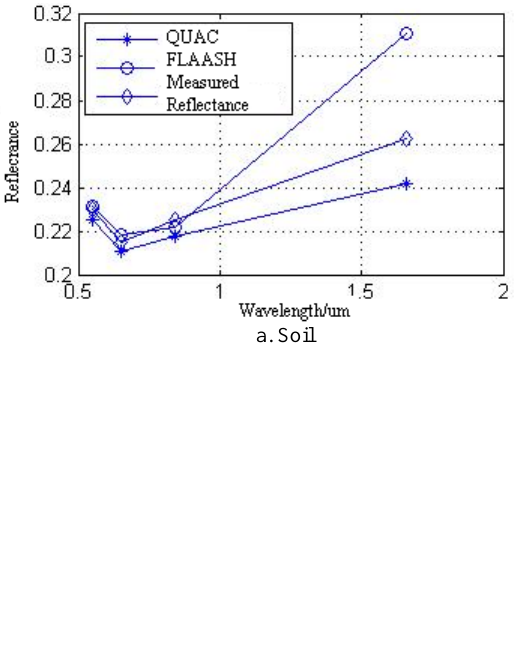
Figure 1. Flow chart of QUAC model